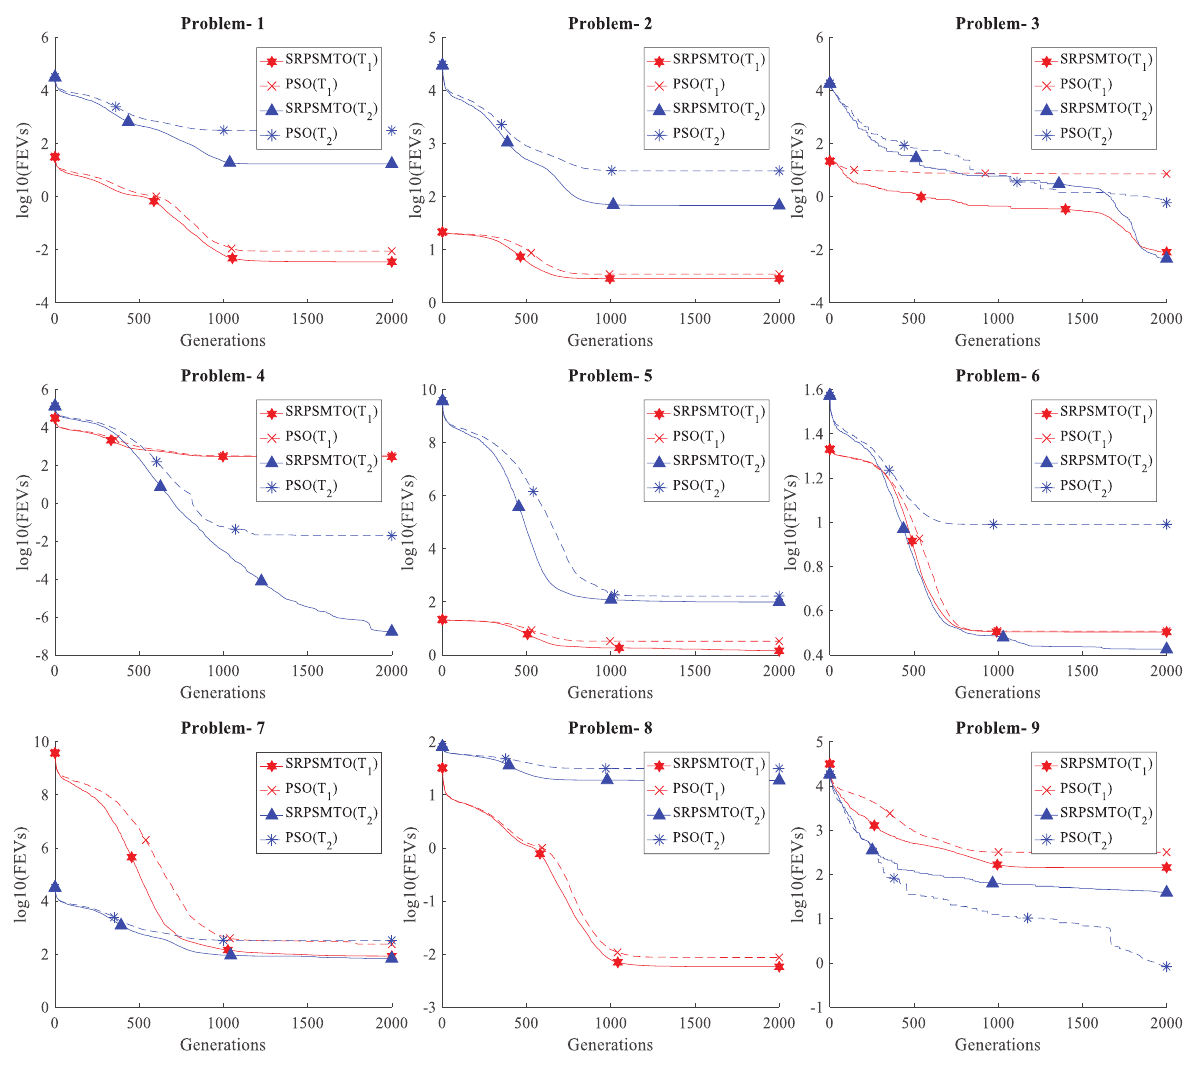
Figure 2. Averaged achieved FEVs convergence curves of the proposed SRPSMTO (i.e., SRPSMTO_V1) versus the PSO on the 9 test problems of test suite